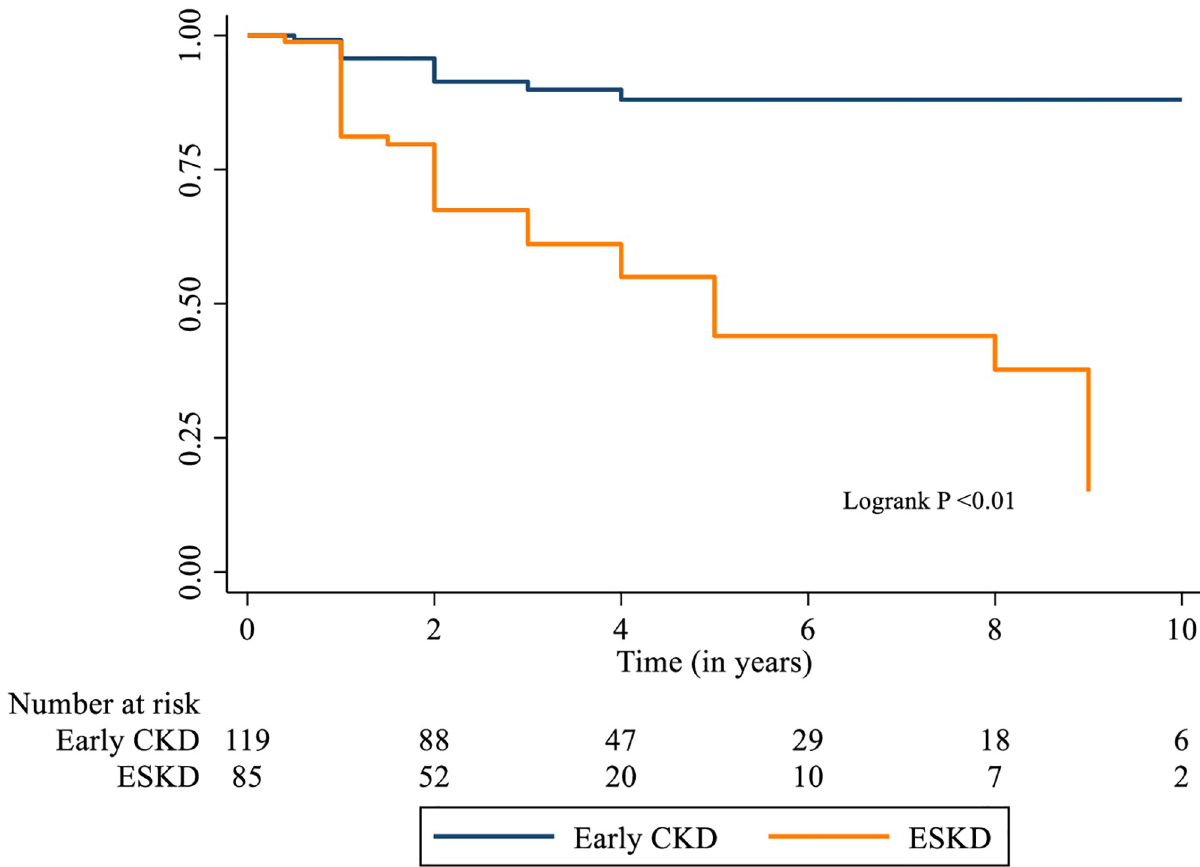
Fig 1. Survival curve of children with early stages of CKD compared to those with later stages (ESRD).